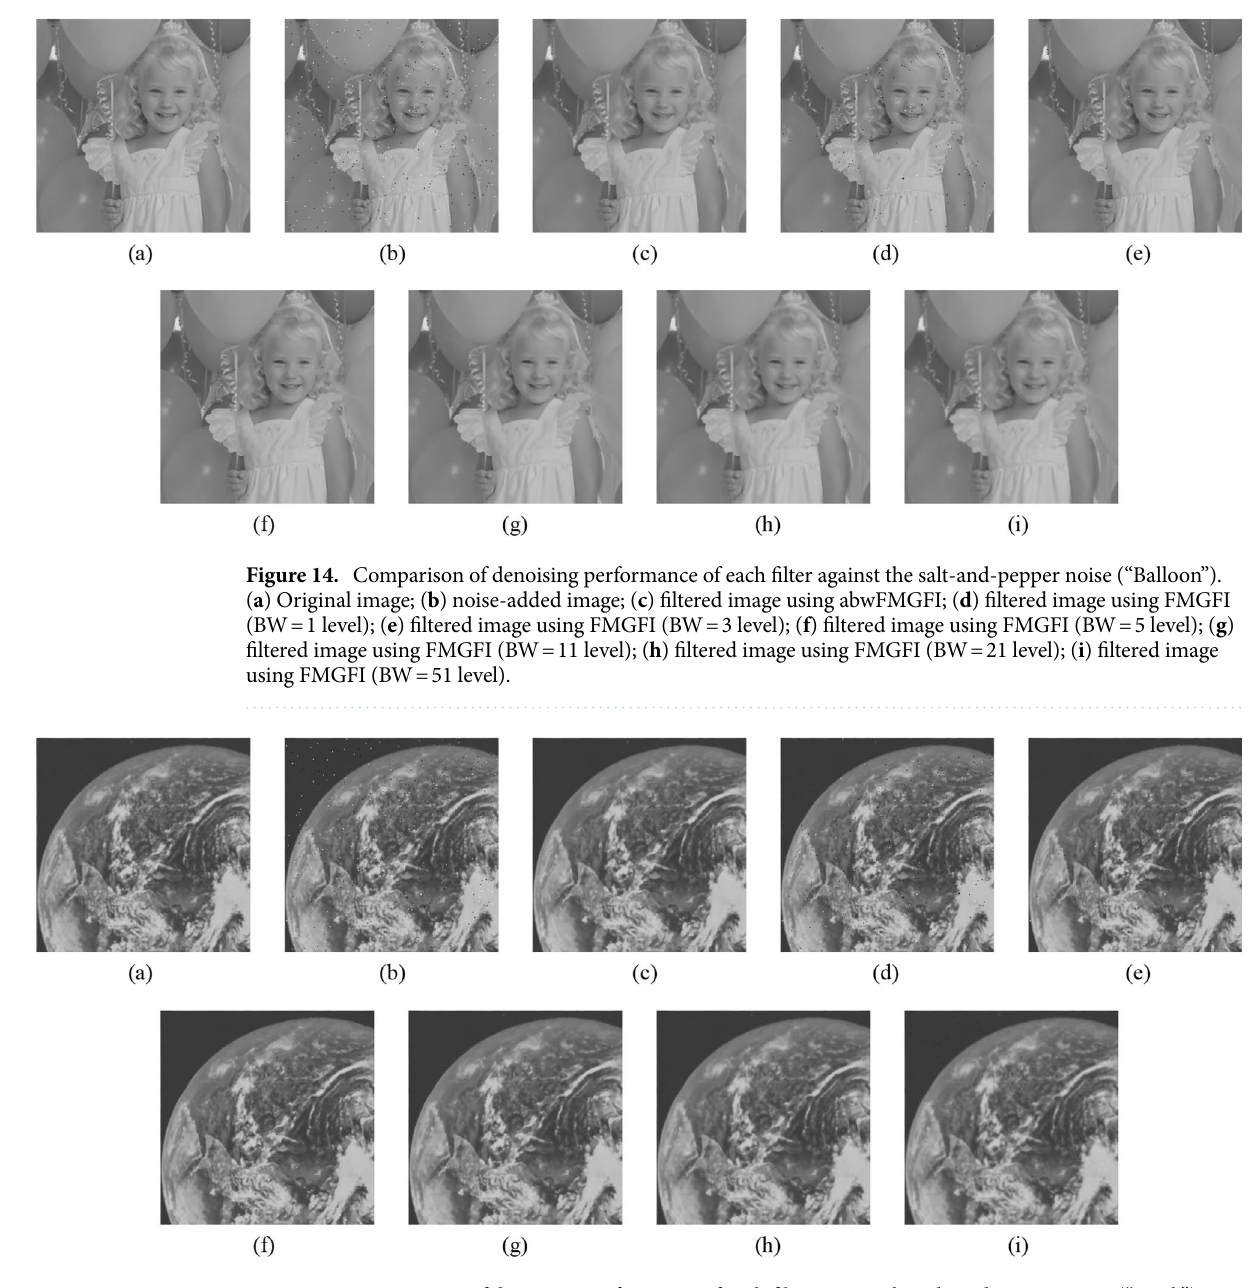
Figure 15. Comparison of denoising performance of each filter against the salt-and-pepper noise (“Earth”). ( a ) Original image; ( b ) noise-added image; ( c ) filtered image using abwFMGFI; ( d ) filtered image using FMGFI (BW = 1 level); ( e ) filtered image using FMGFI (BW = 3 level); ( f ) filtered image using FMGFI (BW = 5 level); ( g ) filtered image using FMGFI (BW = 11 level); ( h ) filtered image using FMGFI (BW = 21 level); ( i ) filtered image using FMGFI (BW = 51